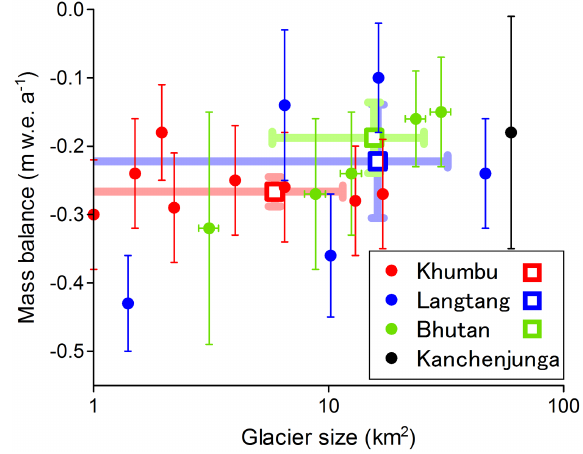
Figure 8. Geodetic mass balance of the debris-covered glaciers (solid circles) in the Himalayas, obtained from the difference be- tween two DEMs generated from declassified satellite images and more recent satellite data. The red, blue, green, and black circles de- note eight glaciers in the Khumbu region (Bolch et al., 2011), five glaciers in the Langtang region (Ragettli et al., 2016), five glaciers in Bhutan (Maurer et al., 2016), and Kanchenjunga Glacier (this study), respectively. Open squares with thick error bars are the area- weighted means and 1 standard deviation for the regional data